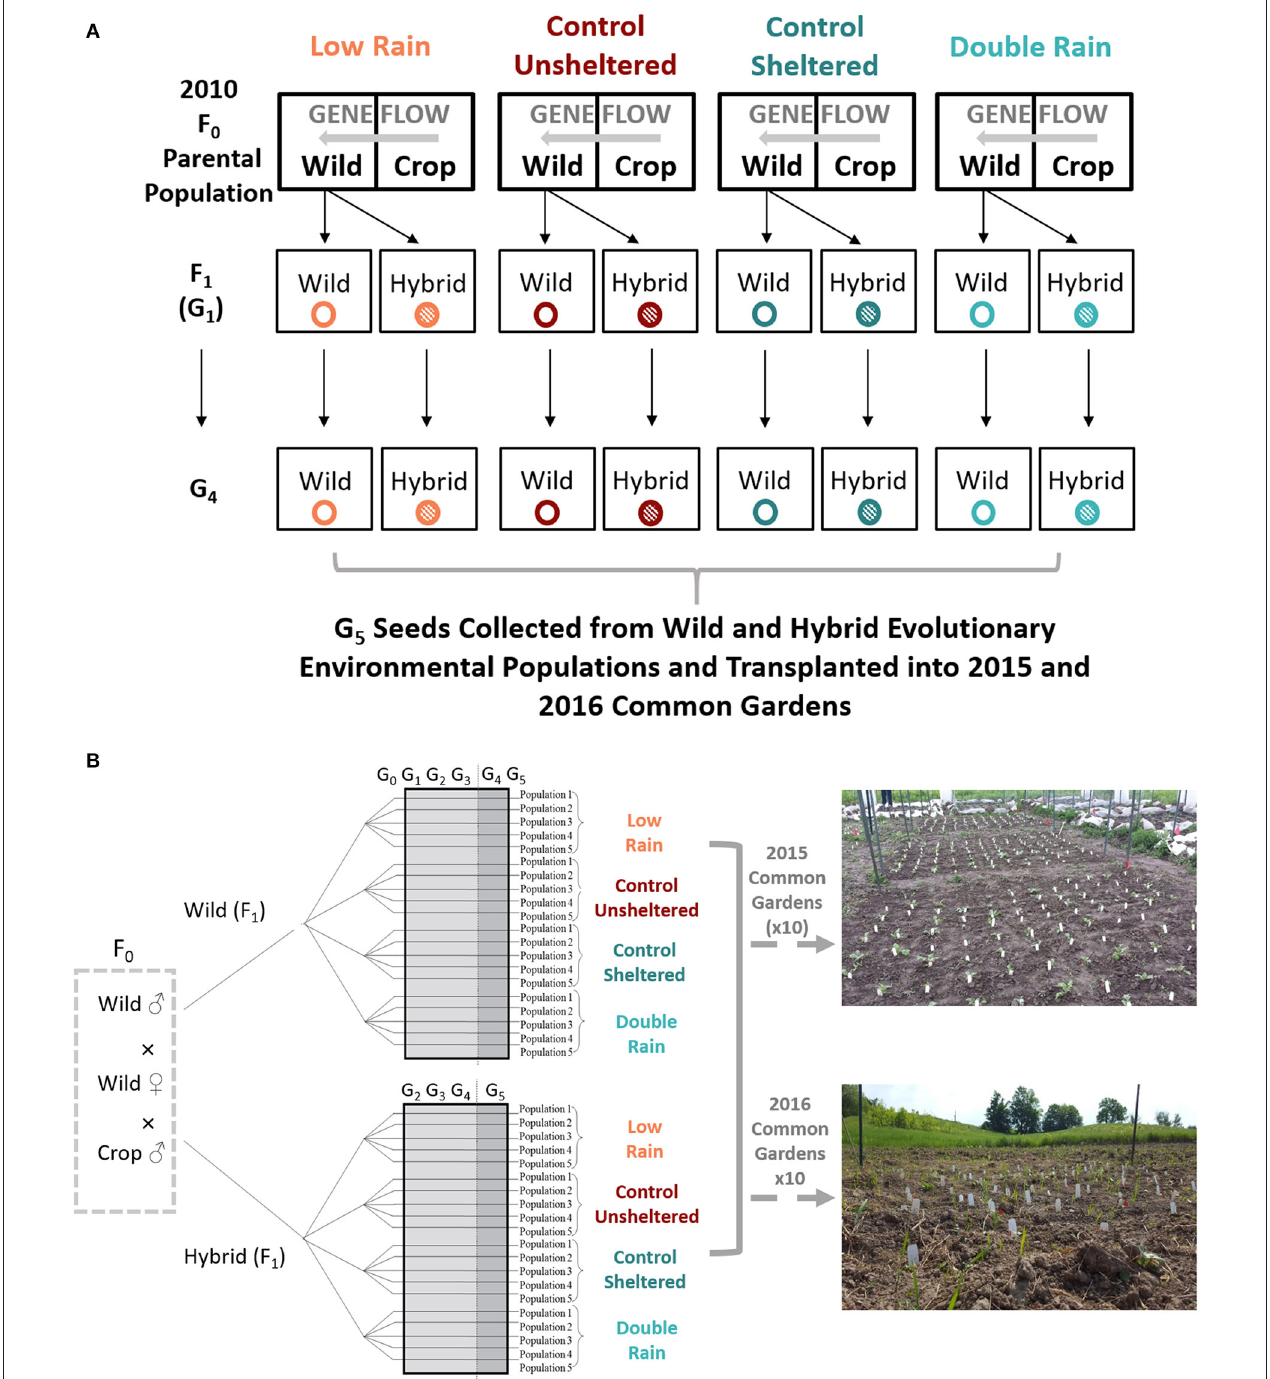
FIGURE 1 | (A) The evolutionary history of fifth generation (G 5 ) wild and hybrid Raphanus populations planted in 2015 and 2016 common gardens. In 2010, cultivated and wild Raphanus seeds were planted into one of four soil moisture treatments (F 0 : Low-Rain, Control-Unsheltered, Control-Sheltered, and Double-Rain; Waterman Farm at Ohio State University in Columbus, Ohio, USA). Gene flow naturally occurred within mixed plots of wild and cultivated plants which gave rise to first-generation (i.e., F 1 /G 1 ) wild ( R. raphanistrum —open colored circles) and crop-wild hybrid ( R. sativus × R. raphanistrum – filled colored circles) seeds. Succeeding wild and hybrid generations (G 2 -G 4 ) from 2011 to 2014 were transplanted into the same four soil moisture environments as F 0 populations (Low-Rain, Control-Unsheltered, Control-Sheltered, and Double-Rain) at the Koffler Scientific Reserve (KSR), King City, Ontario, Canada. (B) Forty wild and hybrid 2nd generation (G 2 ) to 4th generation (G 4 ) plants (five replicate populations per watering treatment) were grown under the same watering conditions at the Koffler Scientific Reserve (KSR) in King City, Ontario, Canada. Fifth generation plants were transplanted and grown in 2015 and 2016 common gardens at KSR.